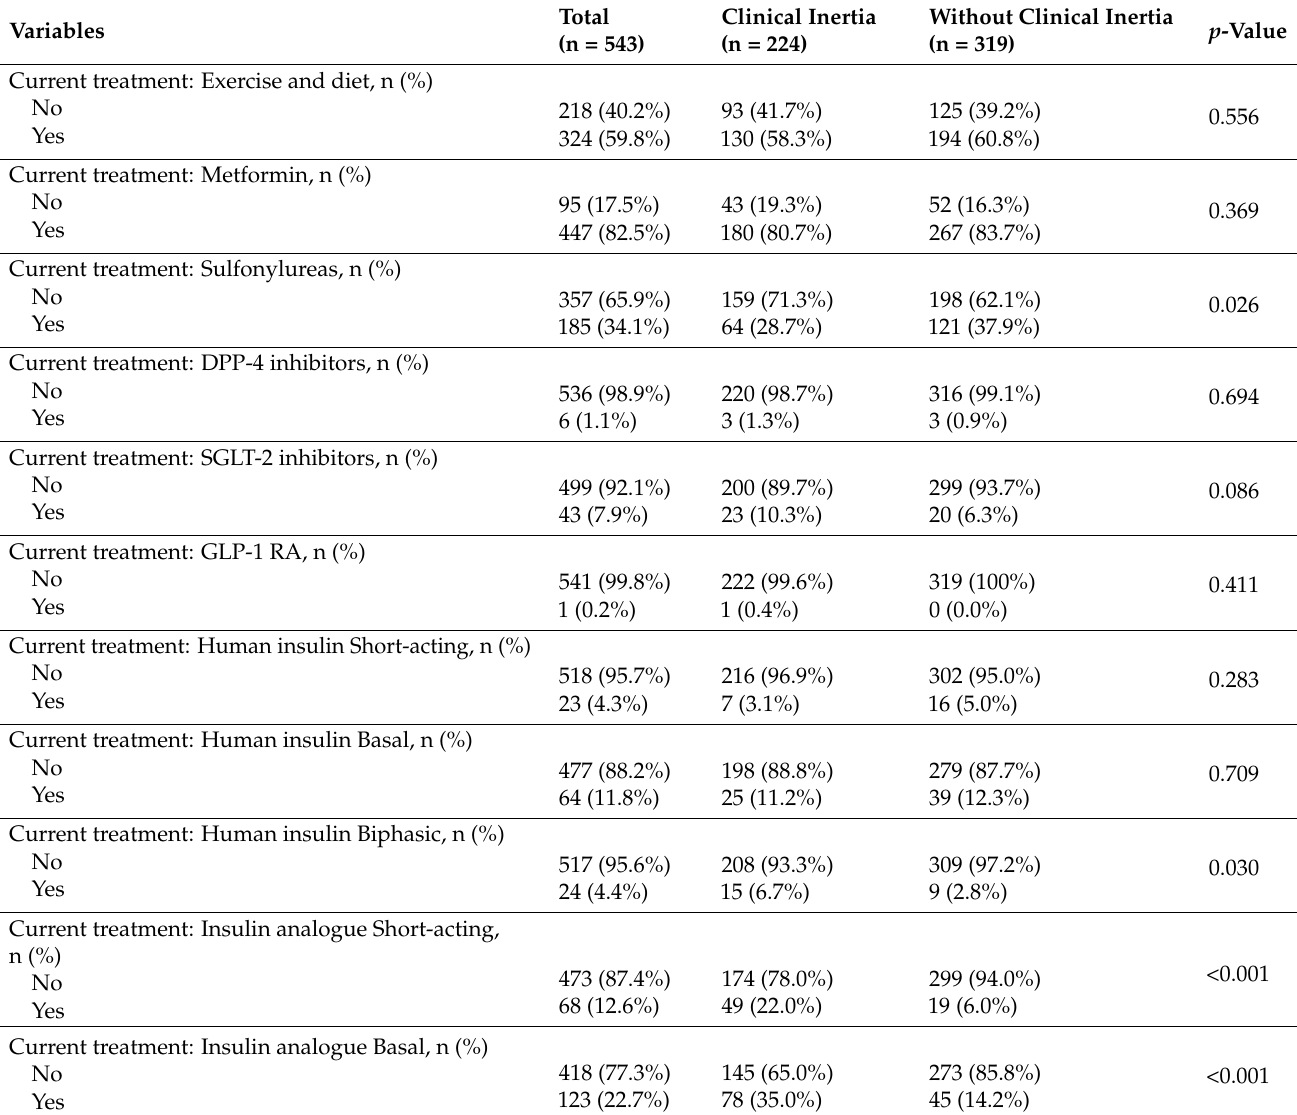
Table 3. Diabetes type 2 treatment characteristics and related clinical